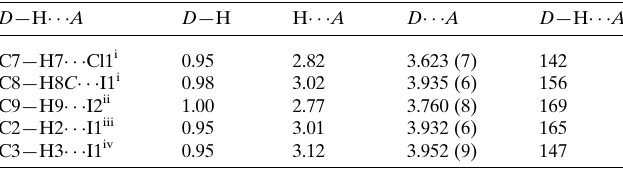
Table 1 Hydrogen-bond geometry (A˚ , (cid:4) ) for 1 .